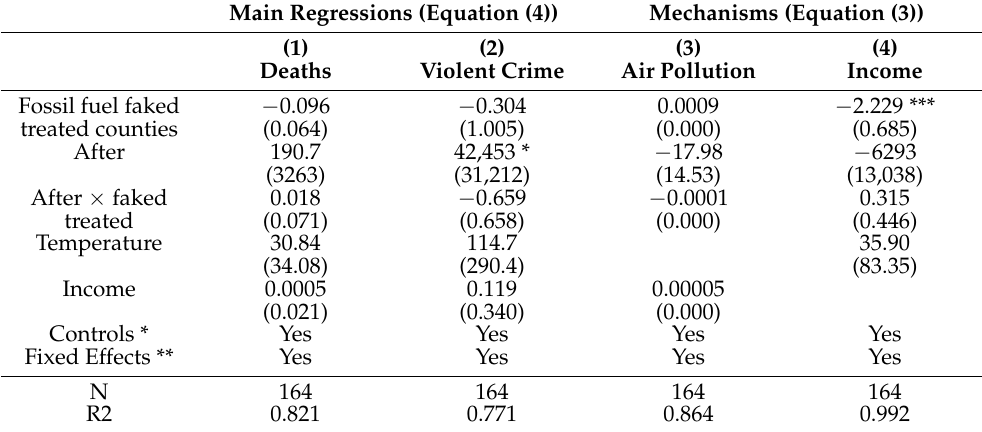
Table 8. Placebo test to detect the true effect in Table 6 with the randomly selected 16 counties from Alaska, Colorado, and North Dakota instead of the treatment counties in California, Massachusetts, and